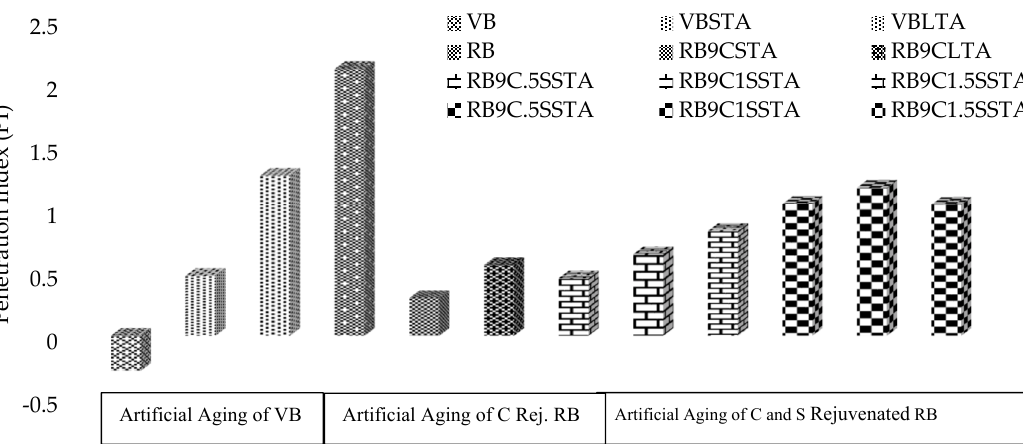
ff ect of rejuvenators and aging process on penetration index (PI) of asphalt Figure 2. Effect of rejuvenators and aging process on penetration index (PI) of asphalt binders. Figure 2. E